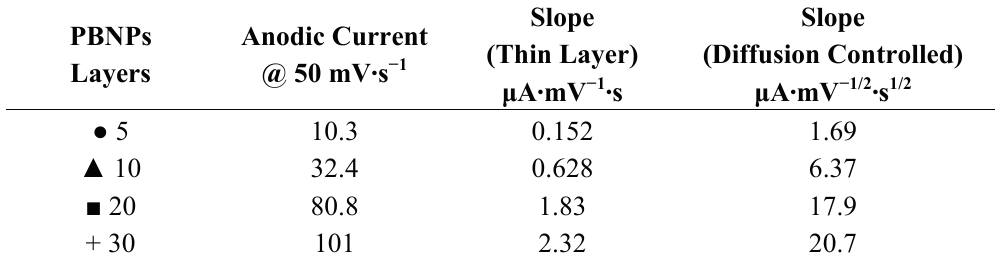
Table 1. Summary of electrochemical parameters from scan rate studies (50 mV·s − 1 vs . Ag/AgCl) for electrodes modified with different numbers of inkjet-printed layers of PBNPs in 0.05 M phosphate buffer, 0.1 M KCl, pH